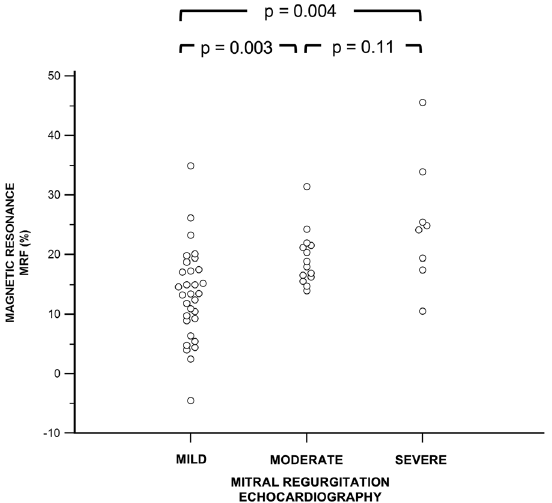
Figure 2. Comparison of mitral regurgitation fraction (MRF) among patients with mild, moderate, and severe mitral regurgitation assessed by echocardiography.